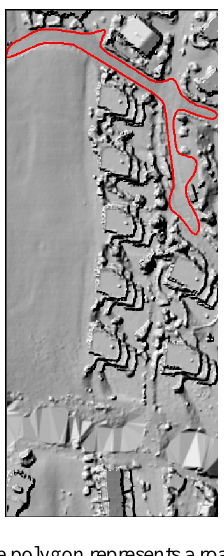
Figure 7. The red line polygon represents a road area selected based on visual analysis of the UAV orthophoto in order to quantitatively compare elevation, slope, and aspect of the two DEMs without the influence of objects such as vegetation, cars, or other features that are known to differ categorically between the two DEMs.